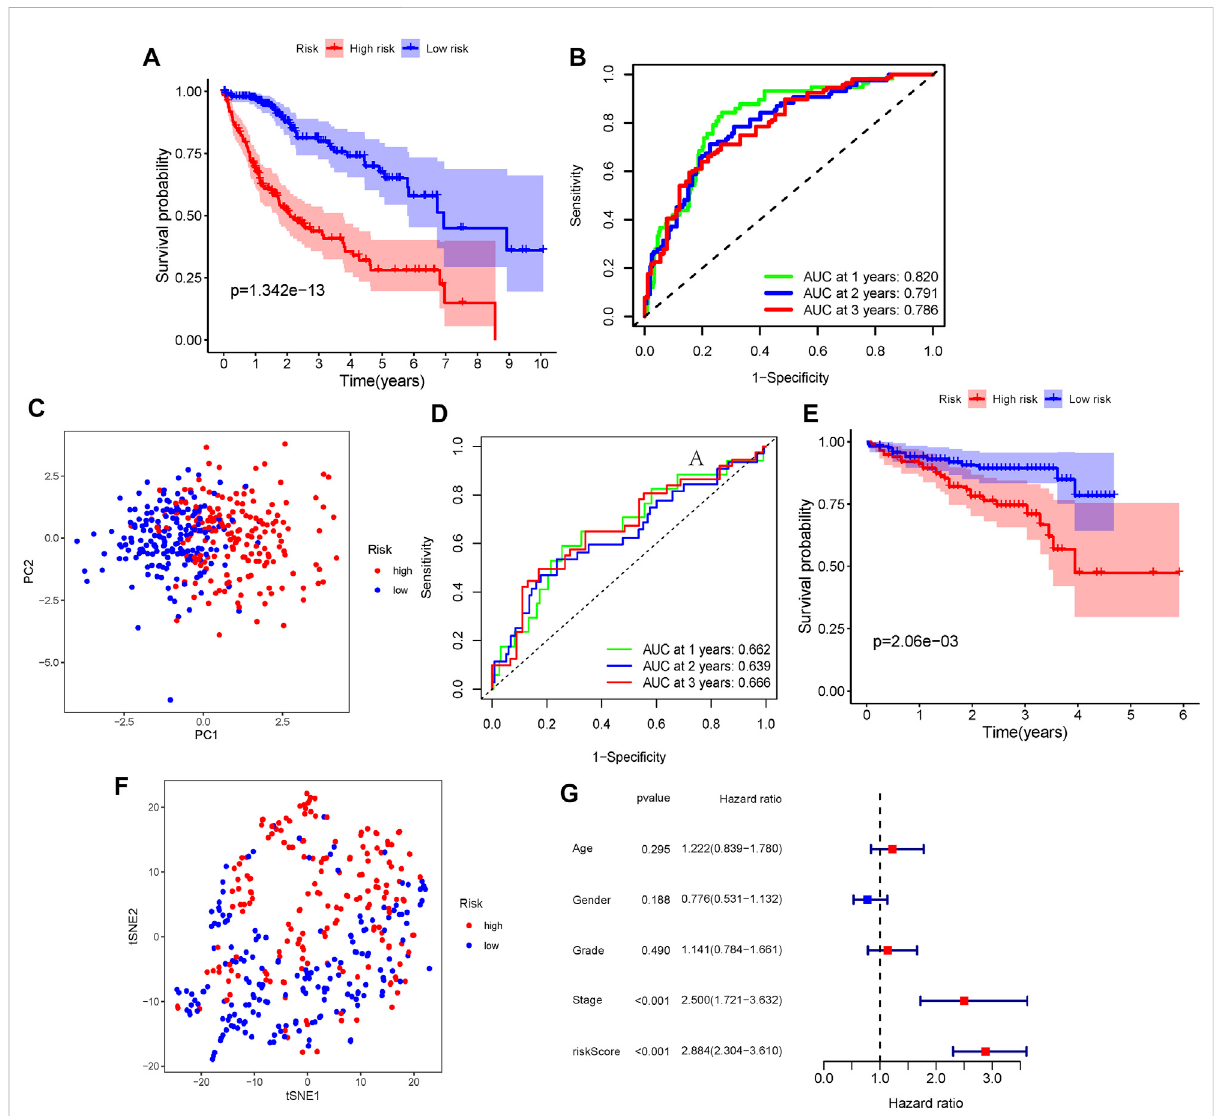
FIGURE 2 Veri fi cationoftheERGsignature. (A) Kaplan – MeiercurvesfortheOSofpatientsbetweenthehigh-riskgroupandlow-riskgroup(dividedbythe ERG signature) in TCGA cohort. (B) AUC of time-dependent ROC curves veri fi ed the prognostic performance of the risk score in TCGA cohort. (D) Kaplan – Meier curves in the ICGC cohort. (E) AUC of time-dependent ROC curves in the ICGC cohort. (C,F) t-SNE and PCA dimension reduction analysis of the high- and low-risk groups based on the risk score in TCGA cohort. (G) Forest plots of univariate Cox regression analyses containing the clinical feature and risk score of the ERG signature in TCGA